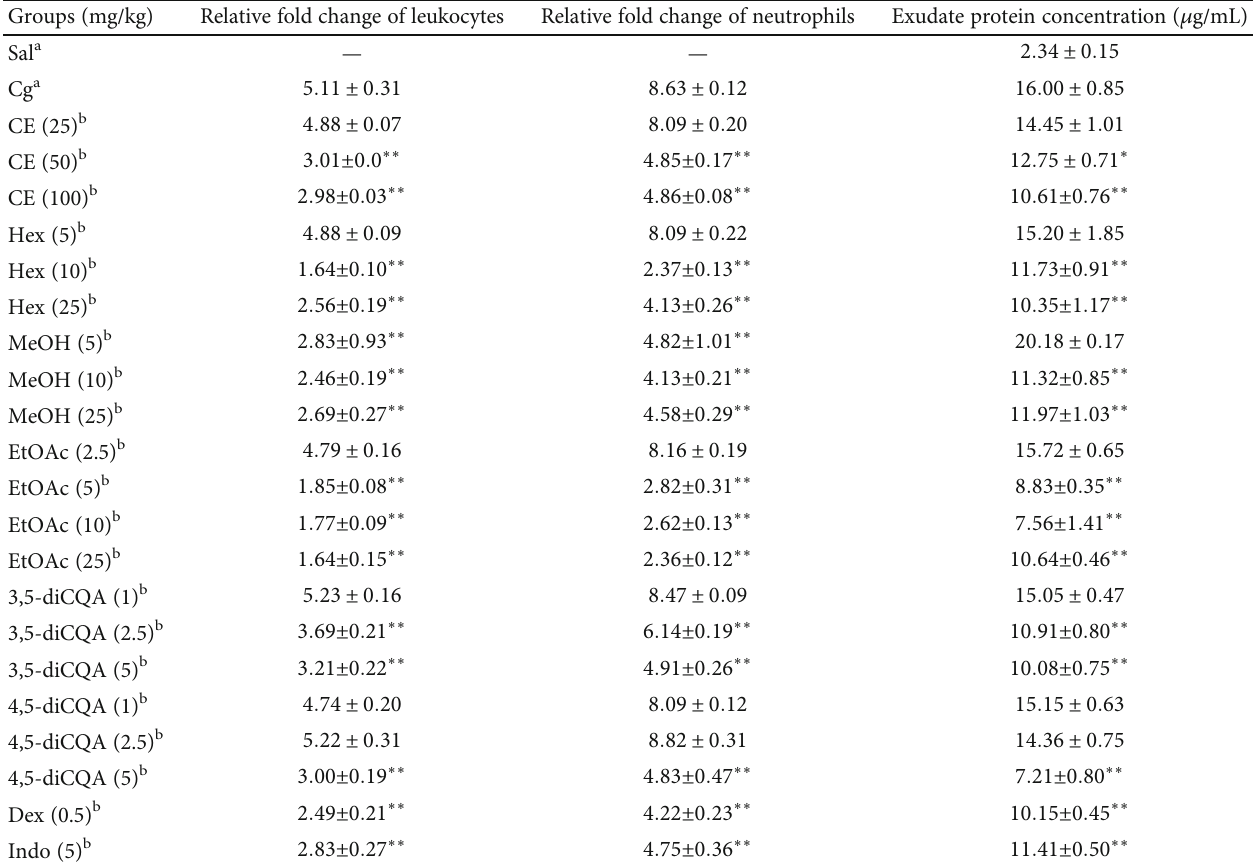
Crude extract (CE: 25 – 100mg/kg), hexane fraction (Hex: 5 – 25 mg/kg), methanol fraction (MeOH: 5 – 25mg/kg), ethyl acetate fraction (EtOAc: 2.5 – 25mg/kg), 3,5-di- O - E -ca ff eoylquinic acid (3,5-diCQA: 1 – 5mg/kg), and 4,5-di- O - E -ca ff eoylquinic acid (4,5-diCQA: 1 – 5mg/kg) obtained from C . pinnati fi da leaves administered 0.5h before pleurisy induction. Sal: negative control group, animals treated only with sterile saline (0.95%); Cg: positive control group, animals treated only with carrageenan (1%); Dex: animals treated with dexamethasone (0.5mg/kg) 0.5h before pleurisy induction; Indo: animals treated with indomethacin (5 mg/kg) 0.5h before pleurisy induction. a Administered by intrapleural route (i.pl.). b Administered by intraperitoneal route (i.p.). Each group represents the mean ± SEM of six animals. ∗ P < 0 : 05 and ∗∗ P < 0 : 01